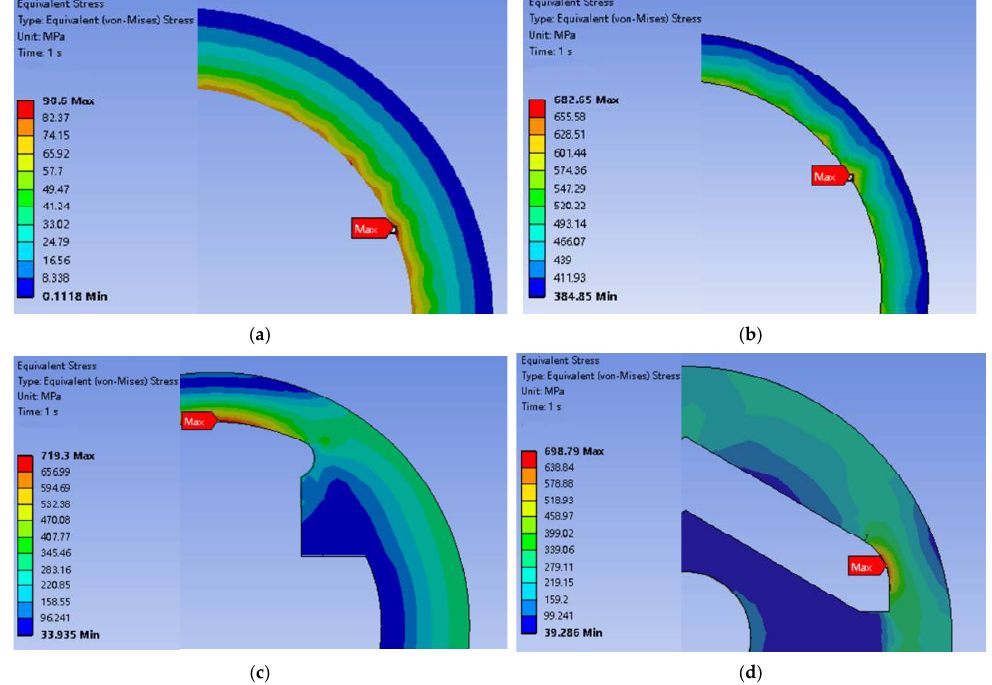
Figure 4. Mechanical stress distribution in the rotor at rated operation conditions (160 krpm). ( a ) M1; ( b ) M2; ( c ) M3; ( d ) M4.